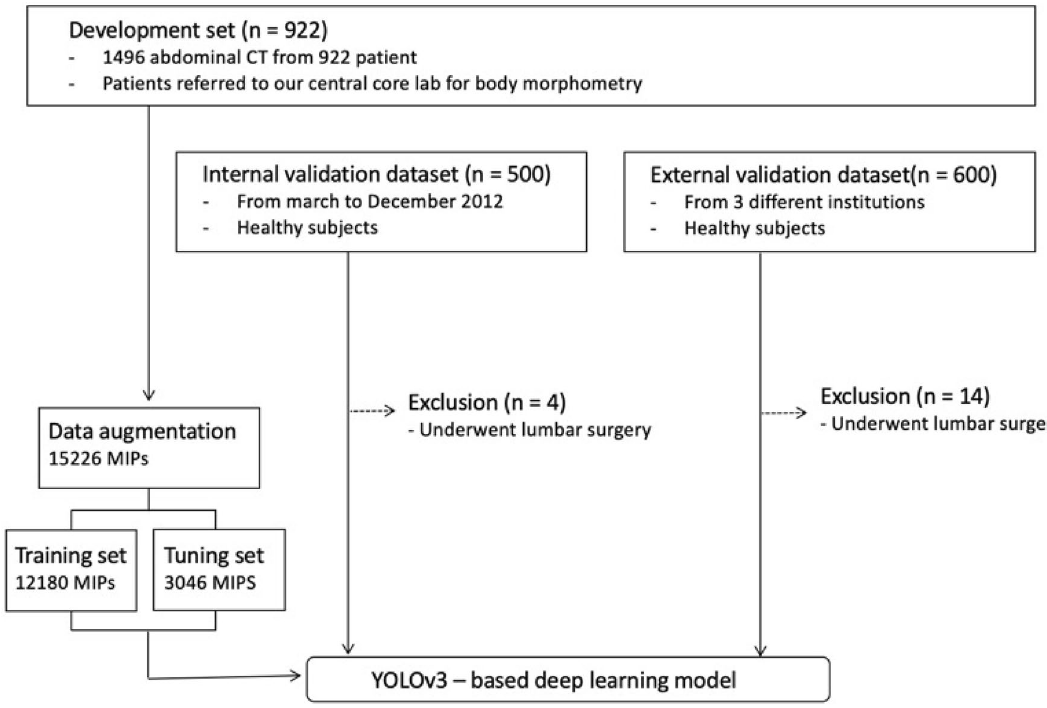
Figure 1. An overview of dataset composition.